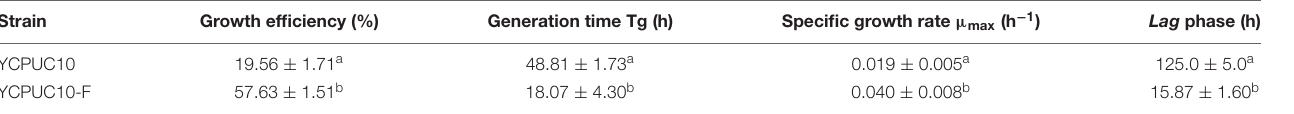
Frontiers in Microbiology | www.frontiersin.org